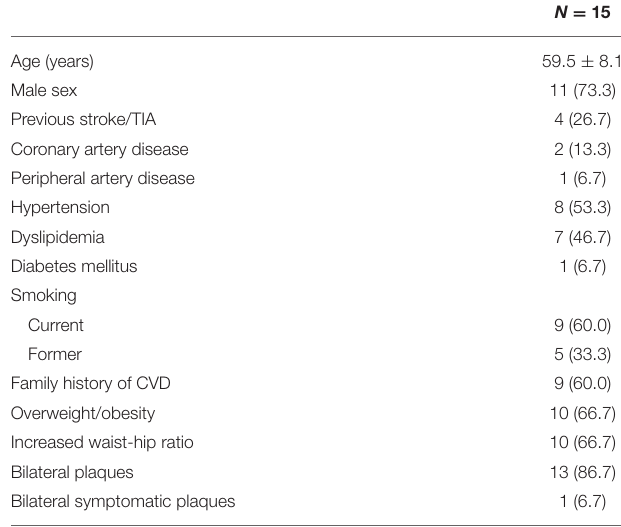
TABLE 1 | Patient characteristics at